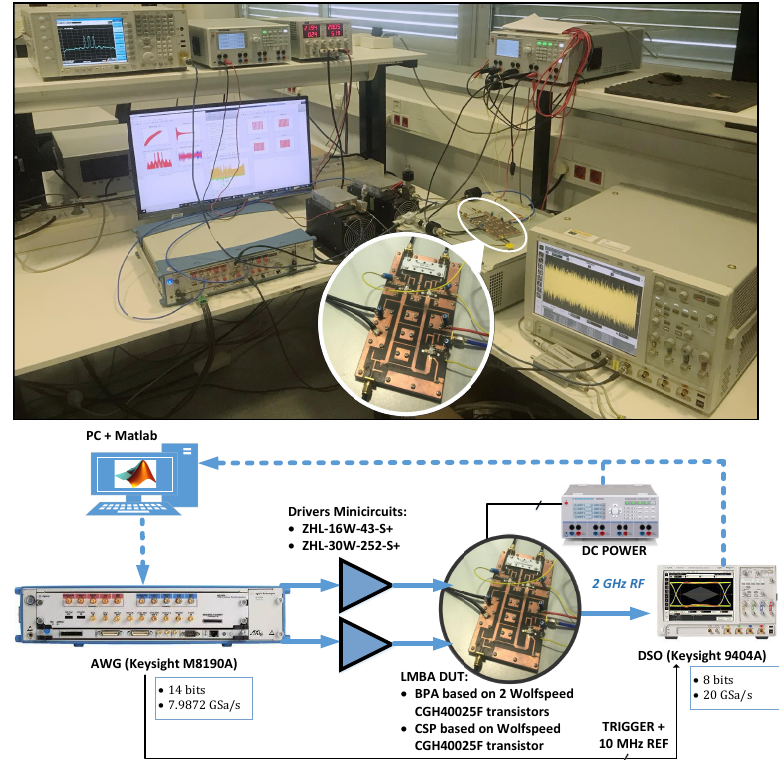
Figure 7. Picture of the test setup employed for experimental